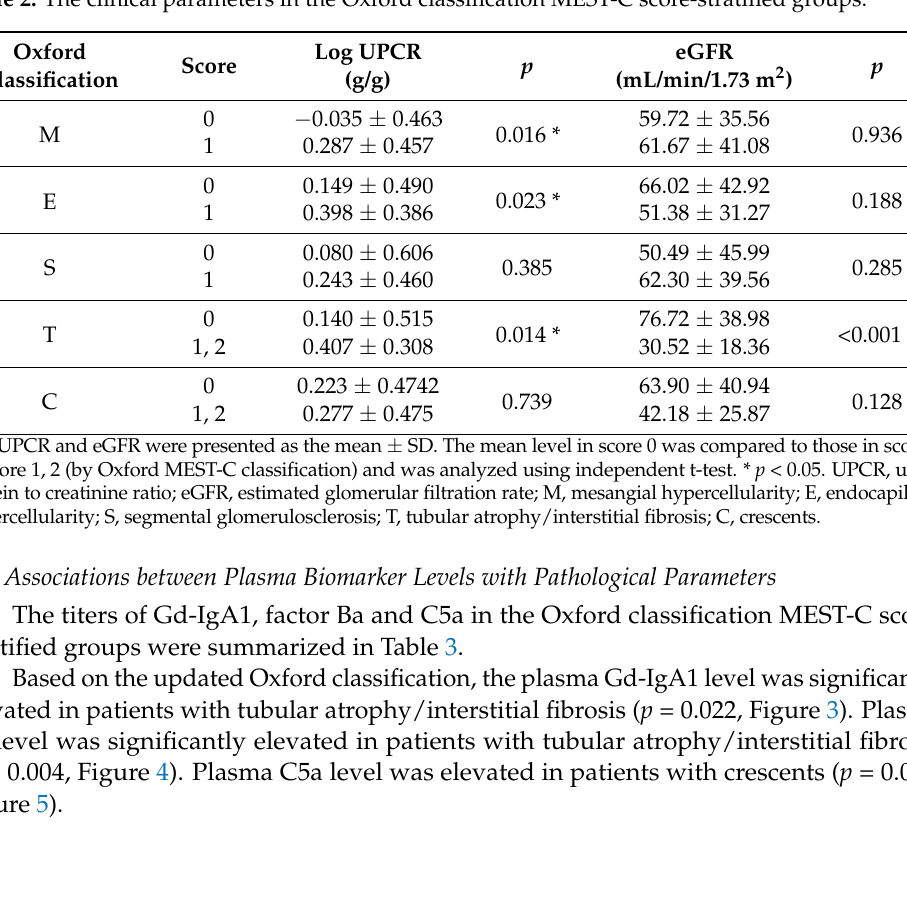
Table 2. The clinical parameters in the Oxford classification MEST-C score-stratified